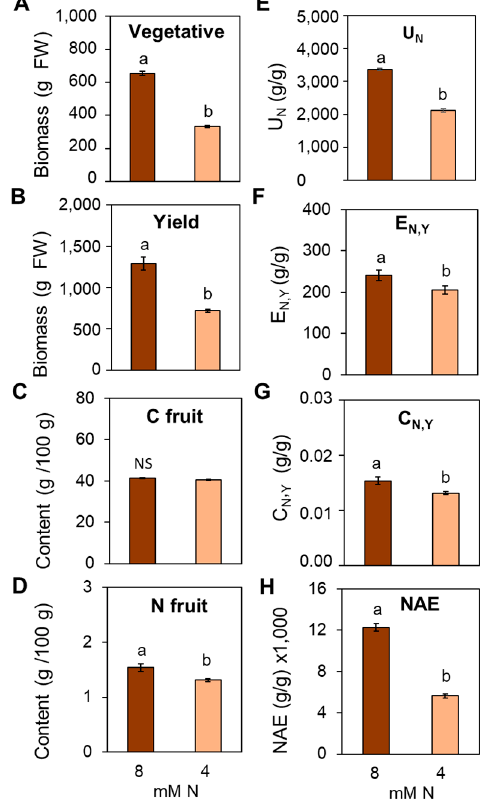
Figure 7. Changes in biomass and nitrogen use for yield in tomato plants grown under suboptimal N supply conditions. Vegetative ( A ) and reproductive ( B ) biomass (g FW) in plants grown under 8 (dark colored bars) and 4 (light colored bars) mM N conditions for 140 days in greenhouse conditions. Carbon ( C ) and nitrogen ( D ) concentration (g/100 g DM) in mature red fruits. Values of ( E ) the N uptake efficiency (U N ; g/g), ( F ) yield-specific N efficiency (E N,Y ; g/g), and ( G ) yield biomass (C N,Y ; g/g) components of ( H ) nitrogen assimilation efficiency (NAE; g/g). Each value (±SE) is the mean of three different determinations. Different letters indicate significant differences ( p < 0.05).